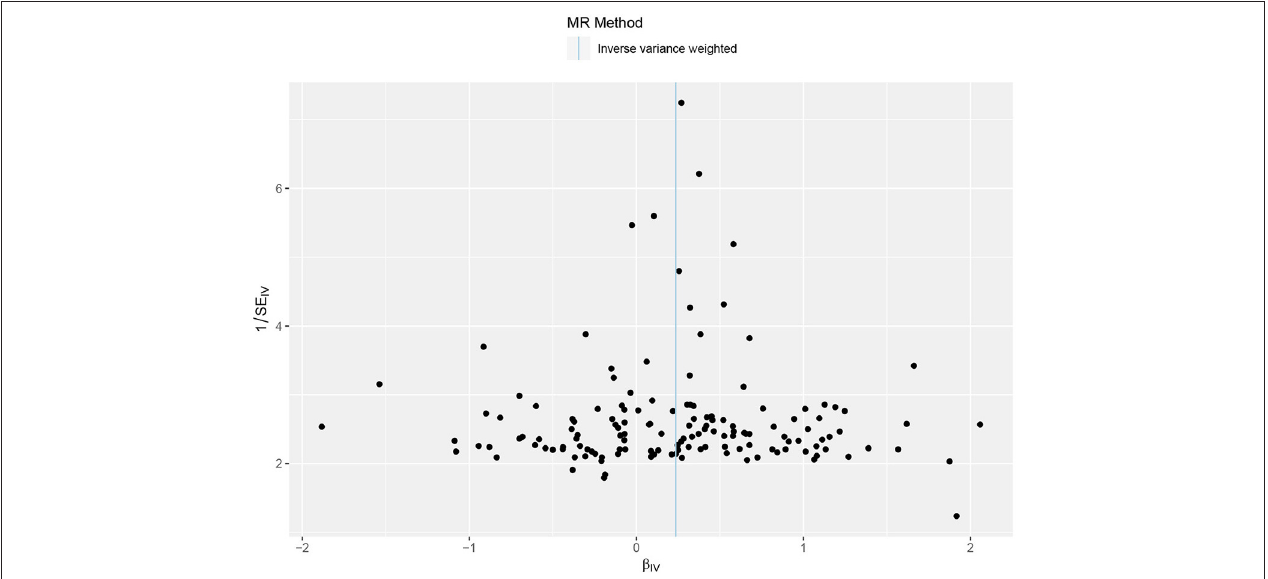
FIGURE 3 | Funnel plot of the Mendelian randomization analysis. The X axis presents the estimate of the causal effect, and the Y axis presents the relevant inverse standard error. The dots indicate each SNP, and the line indicates the overall estimate using IVW method. SNP, single-nucleotide polymorphism; IVW, inverse variance-weighted.